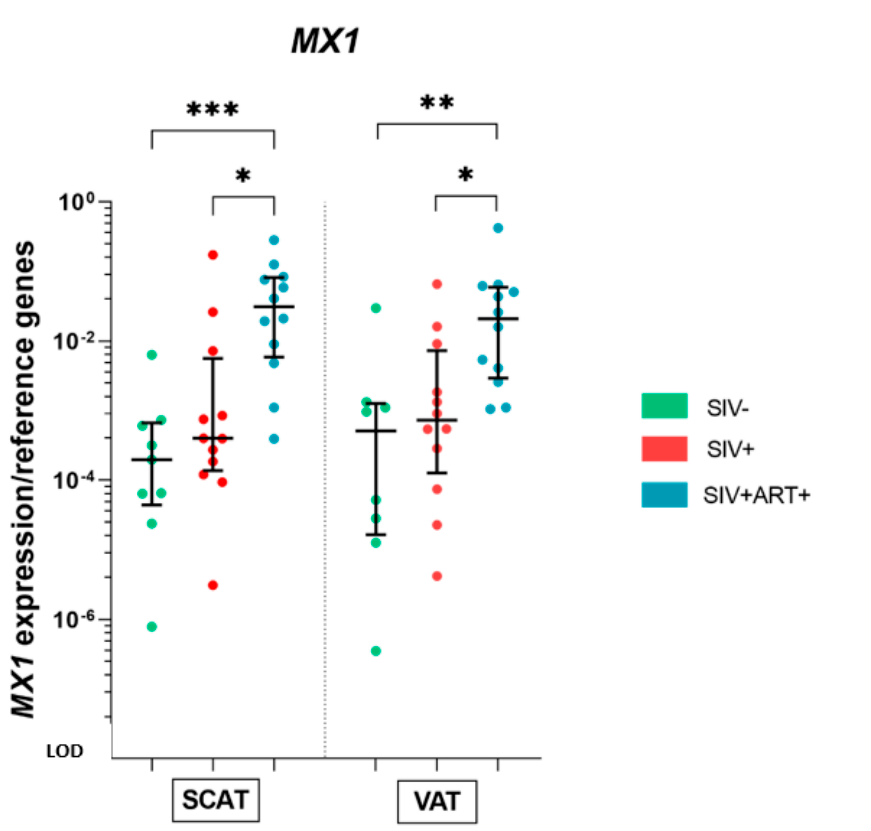
Figure 6. Whole-tissue analysis of type I interferon-stimulated gene expression in AT. RT-qPCR analysis of the mRNA expression of a gene encoding a type I interferon-stimulated gene ( MX1 ) within the SCAT and VAT in the three groups of animals: SIV − (green), SIV+ (red), and SIV+ART+ (blue). The expression of the gene of interest was compared with that of the 18S and PPIA housekeeping genes. The LOD was set to the difference vs. the mean level of housekeeping gene expression after 20 cycles, i.e., a 10 − 8 -fold difference. Expression of MX1 in SCAT (left) and VAT (right) for the three groups. The data are quoted as the median [IQR]. Kruskal–Wallis tests associated with Dunn’s multiple comparison test or Mann–Whitney tests were used for unpaired and paired comparisons, respectively. Only significant results and trends are shown: * p < 0.05, ** p < 0.005, *** p < 0.001.